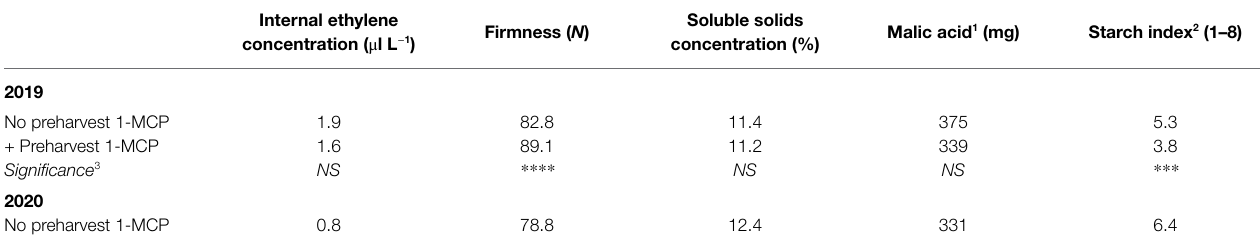
TABLE 1 | Maturity indices of ‘Gala’ apples at harvest